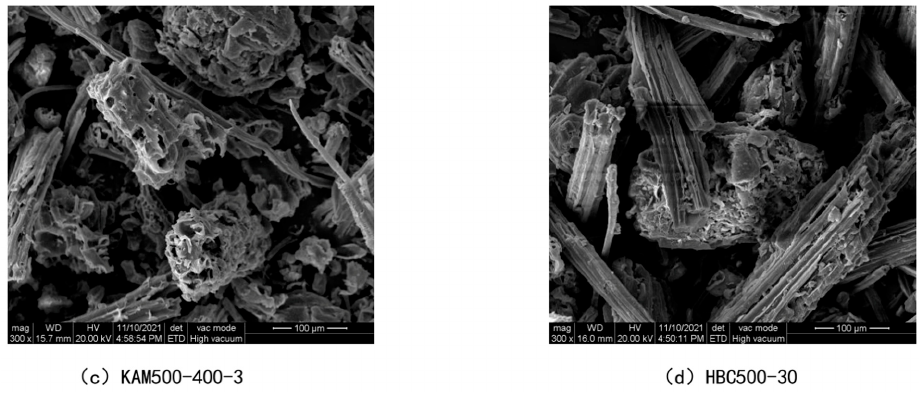
Figure 6. SEM images of bamboo charcoal and modified bamboo charcoal.